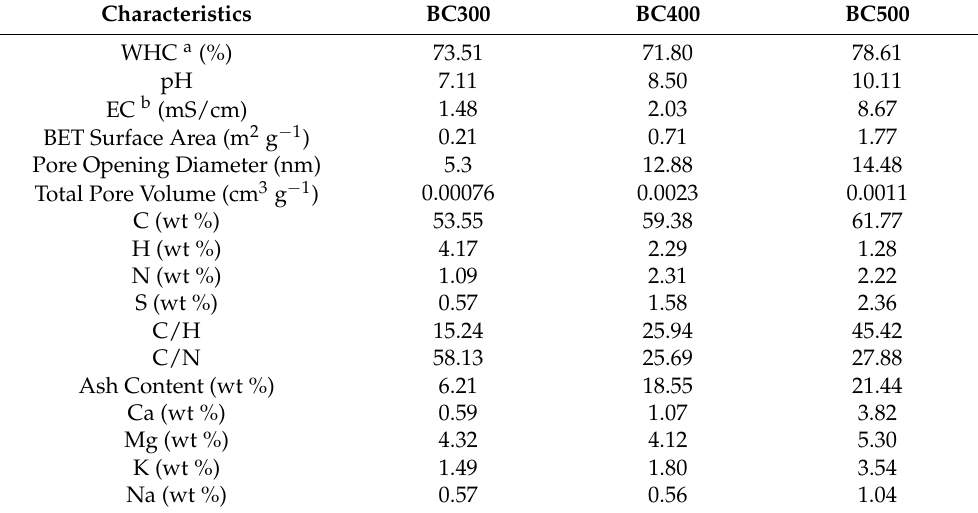
Table 1. Physicochemical characteristics of biochars from tamarisk ( T. chinensis Lour) stems.